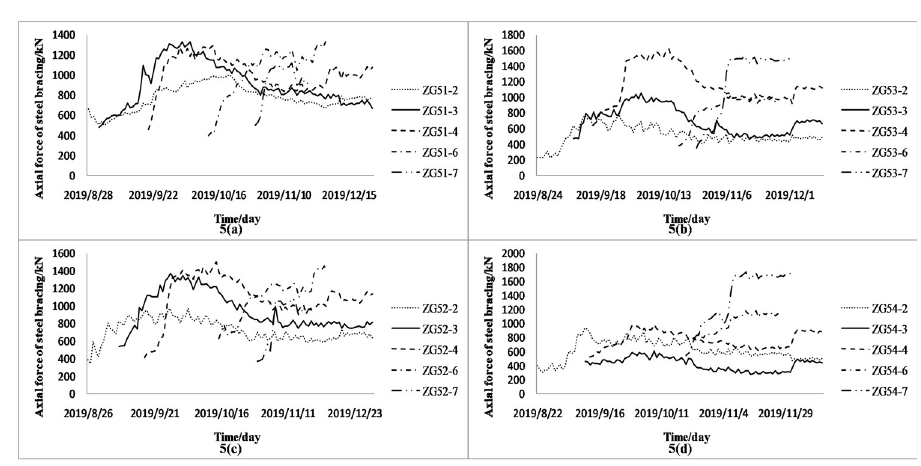
Fig 5. a-d. ZG54 group 2–4 and 6–7 support axial force.